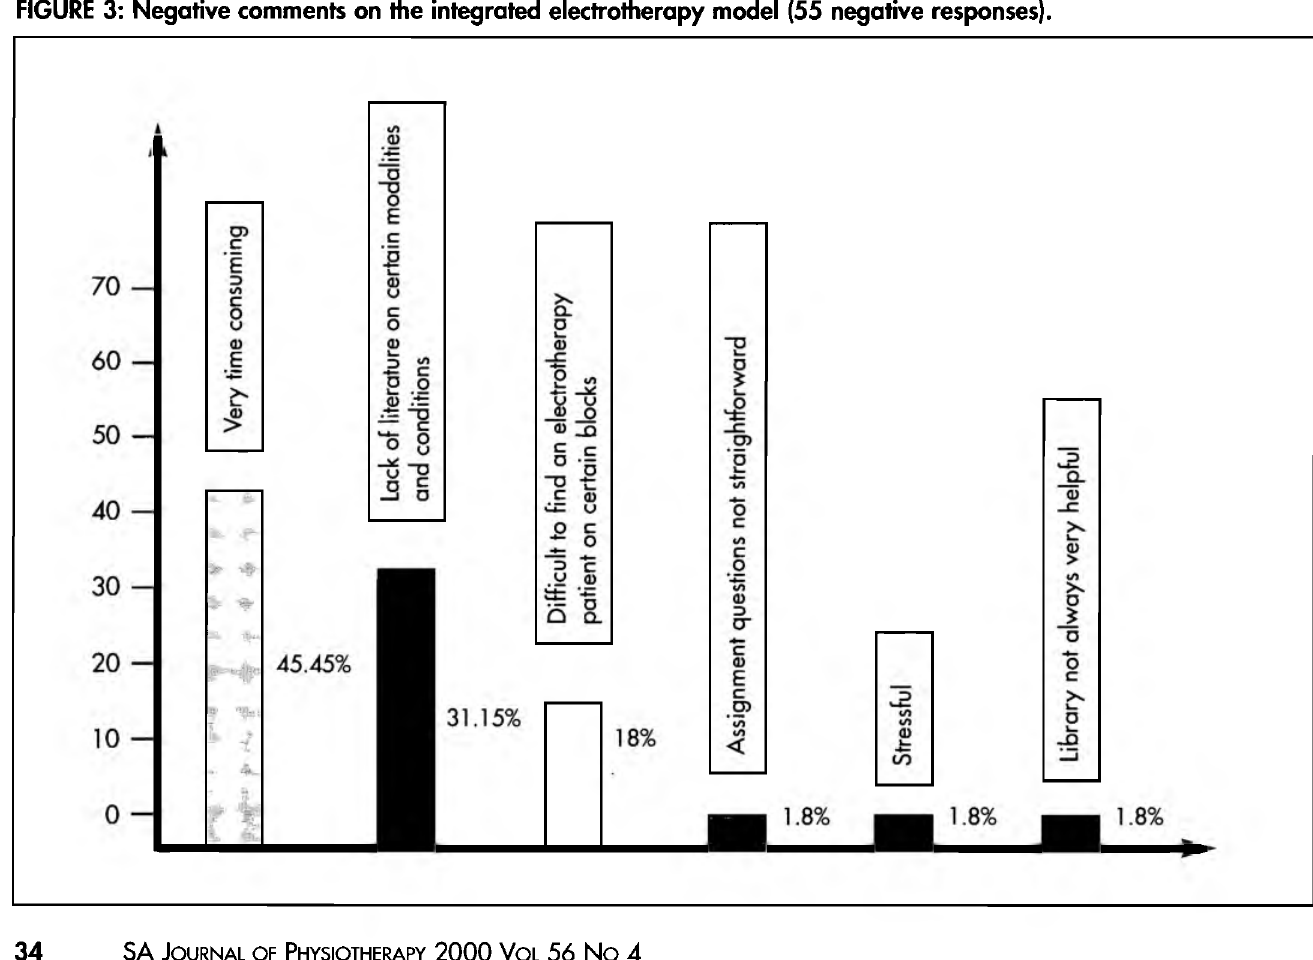
FIGURE 3: Negative comments on the integrated electrotherapy model (55 negative